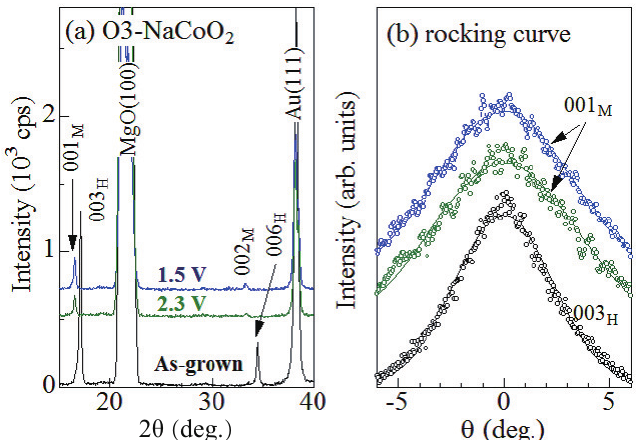
Figure 2. ( a ) X-ray diffraction (XRD) pattern of the as-grown, 2.3 V, and 1.5 V films. Values in parentheses represent indexes in the trigonal [hexagonal (H) setting] and monoclinic (M) structures. ( b ) rocking curve at the 003 H , 001 M , and 001 M reflections of the as-grown, 2.3 V, and 1.5 V films, respectively. Solid curves are results of the least-squares fittings with Gauss functions.